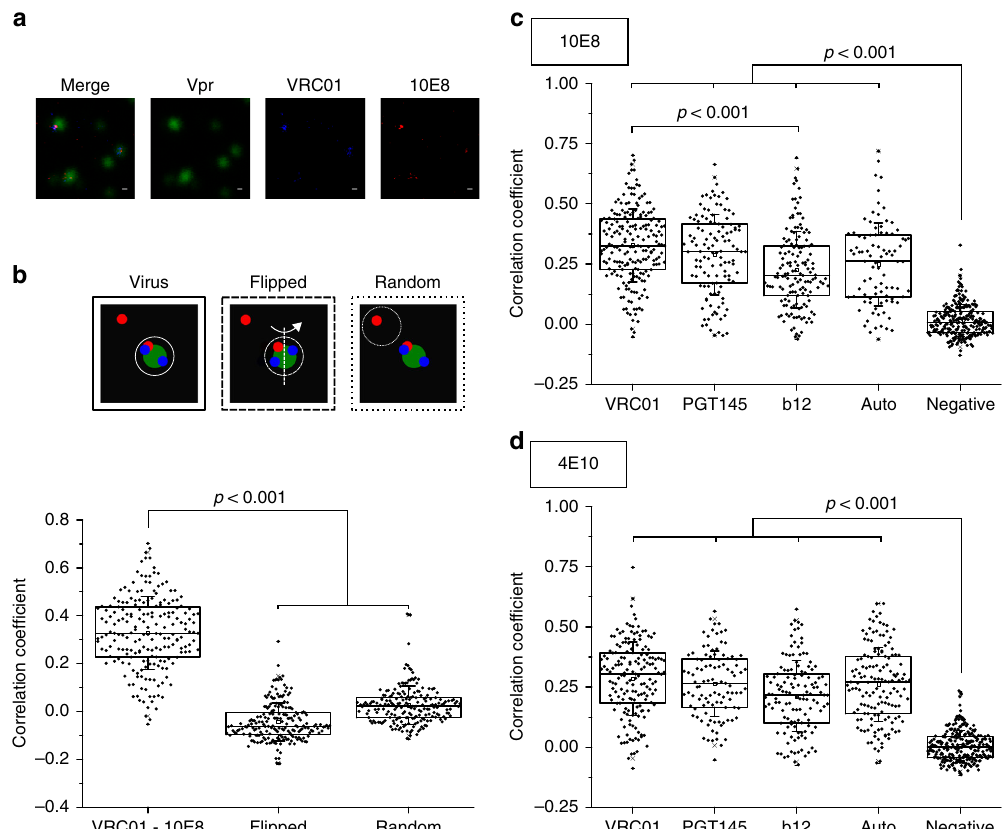
Fig. 3 Dual color STED colocalization analysis of anti-gp120 and anti-MPER antibodies bound to Env NL4-3 in HIV-1 virions. a Representative images of a colocalization experiment. Vpr.eGFP (green), VRC01 (STAR 600, blue, secondary labeling), 10E8 (KK114, red, direct labeling). Scale bars are 100 nm. b Example of colocalization analysis. Pearson ’ s correlation coef fi cient for VRC01 and 10E8-KK114 ( n = 201). Flipped: mirror image of one of the channels. Random: correlation in random ROIs negative for Vpr.eGFP. c Pearson ’ s colocalization coef fi cients obtained for 10E8-KK114 in combination with STAR 600- labeled VRC01 ( n = 201), PGT145 ( n = 120), b12 ( n = 147), and 10E8 itself (Auto) ( n = 89). d Pearson ’ s colocalization coef fi cients obtained for